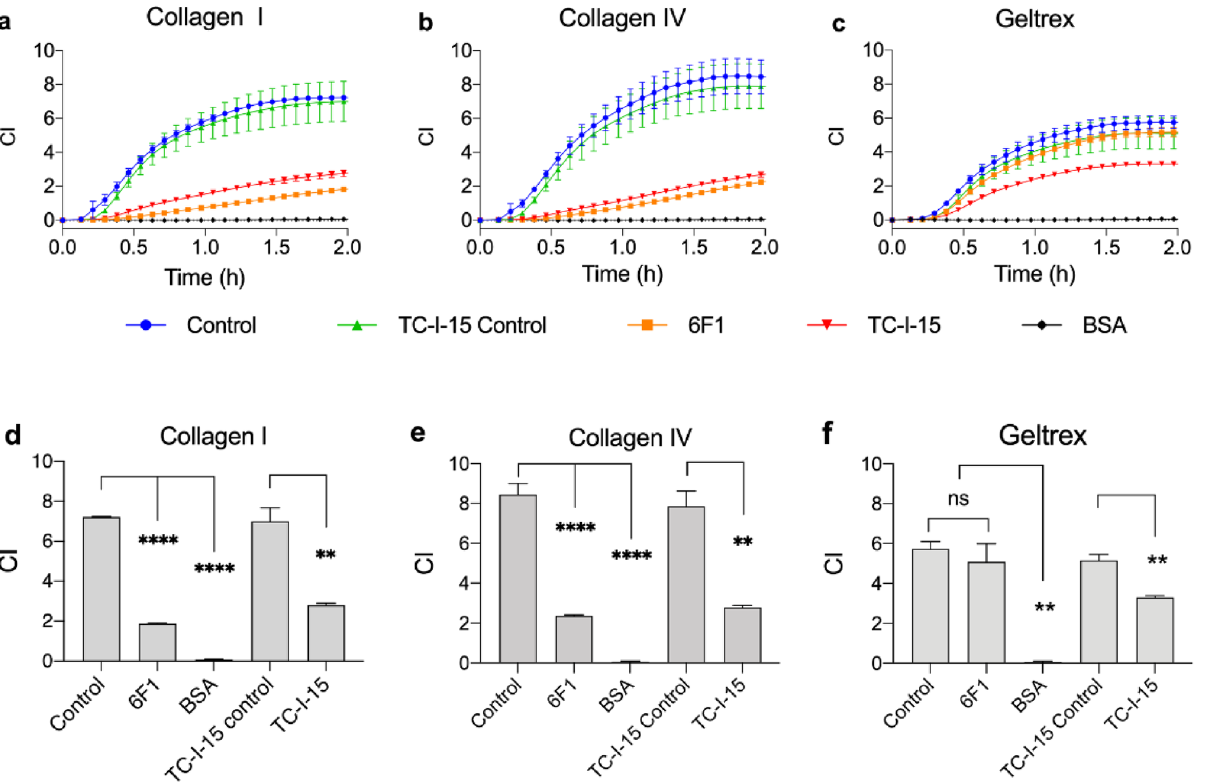
Figure 4. xCELLigence real time adhesion assays determining the effect of integrin inhibition on HUVEC adhesion to ( a ) collagen I, ( b ) collagen IV, and ( c ) Geltrex using 200 µg/ml TC-I-15 (red) and 10 µg/ ml 6F1 (orange). Control (blue), TC-I-15 control (green) and BSA (black) are also shown. Panels ( d–f ) show the endpoint analysis of the data. Mean ± SEM from one of two independent repeats performed in